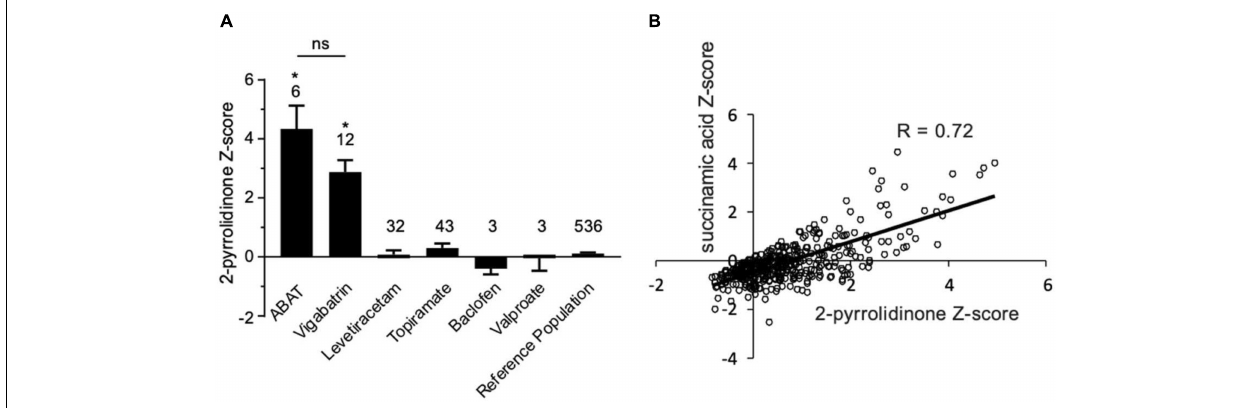
FIGURE 4 | Box plot profile for 2-pyrrolidinone levels detected in plasma for all clinical samples. (A) Z -scores for all clinical EDTA plasma samples are plotted using a box plot format. ABAT cases show elevated Z -scores for 2-pyrrolidinone versus those patients without GABA-transaminase deficiency and treated with vigabatrin, topiramate, and/or valproate. If patients were receiving vigabatrin in addition to other treatments, they were grouped with vigabatrin. Bars represent the mean +/– the standard error of the mean (SEM) of the Z -scores for 2-pyrrolidinone for each group. The numbers above the bars represent the number of unique patient samples for each group. * p < 0.05. NS indicates a comparison which was not statically significant, p > 0.05. (B) Correlation of 2-pyrolidinone levels to succinamic acid levels in clinical plasma samples. Samples which had both 2-pyrrolidinone and succinamic acid Z -scored ( n = 409) are plotted showing a significant positive correlation with these two